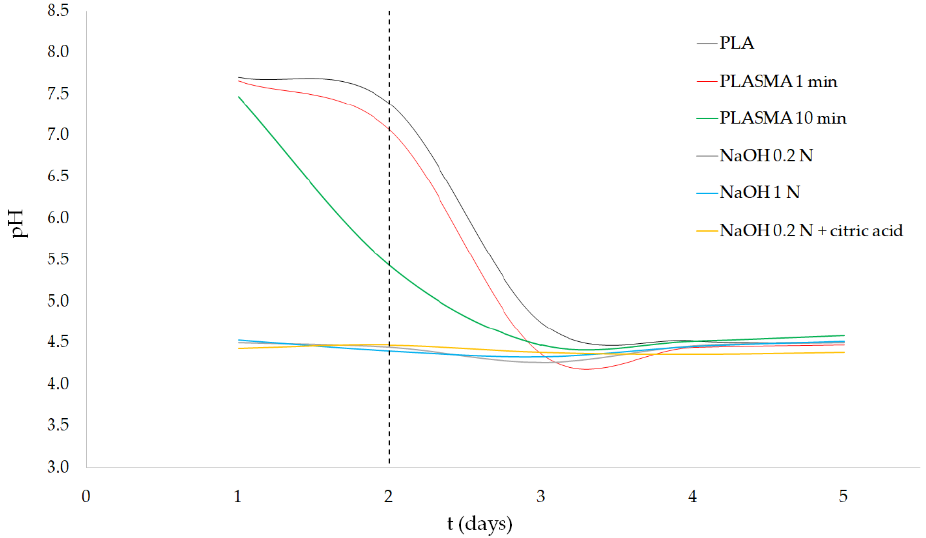
Figure 5. Enzymatic degradation test results of surface-treated samples: pH variation.